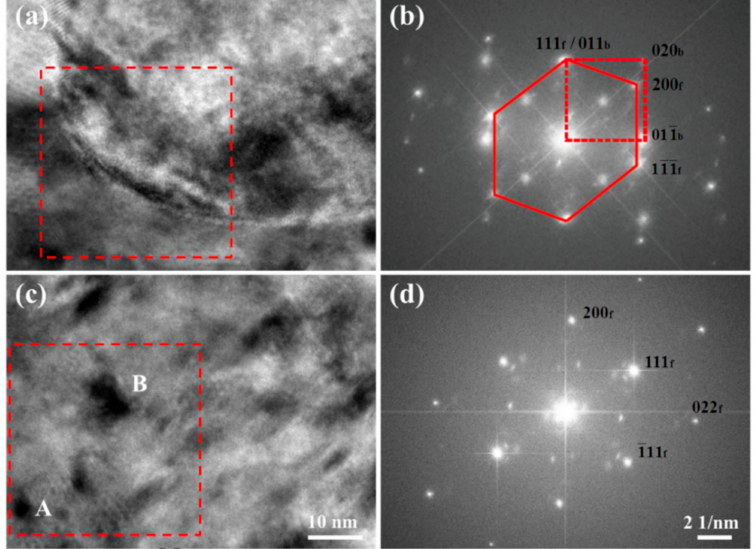
Figure 9. ( a , c ) High-resolution transmission electron microscopy (HRTEM) analyses on the Fe particle and initial decomposition product of the C01 specimen, respectively and ( b , d ) di ff ractograms taken from the enclosed area with dotted lines in ( a ) and ( c ), respectively. Zone axis: [011] f